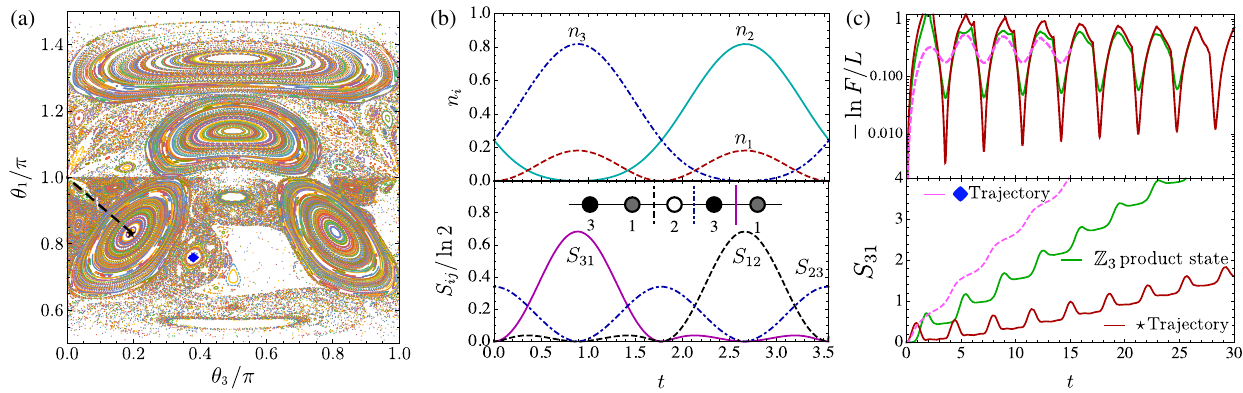
FIG. 2. (a) Poincar´e sections at θ 2 ¼ 0 for a three-site unit cell reveal mixed phase space with large regular regions. A stable periodic orbit that gives rise to robust revivals is denoted by star, while diamond denotes a longer orbit that does not give rise to revivals in exact dynamics. The dashed line represents a particular cut through the regular region, discussed in Sec. II C. (b) Variational TDVP prediction for the local density of the Rydberg excitation (top) and the entanglement entropy (bottom) for the shortest-period trajectory labeled by star on the Poincar´e section in (a). The inset shows the unit-cell choice and entanglement cuts. (c) Quantum dynamics for j Z 3 i initial state and two entangled initial states marked in (a) obtained from iTEBD with χ ¼ 900 . Top: The decay of fidelity per spin has regular minima that correspond to revivals of fidelity in a finite-size system. Bottom: Entanglement entropy. The stable “ star ” trajectory features a better fidelity revival, as well as strongly suppressed entanglement growth. The growth of entanglement limits the iTEBD simulation to shorter times for j Z 3 i , diamond